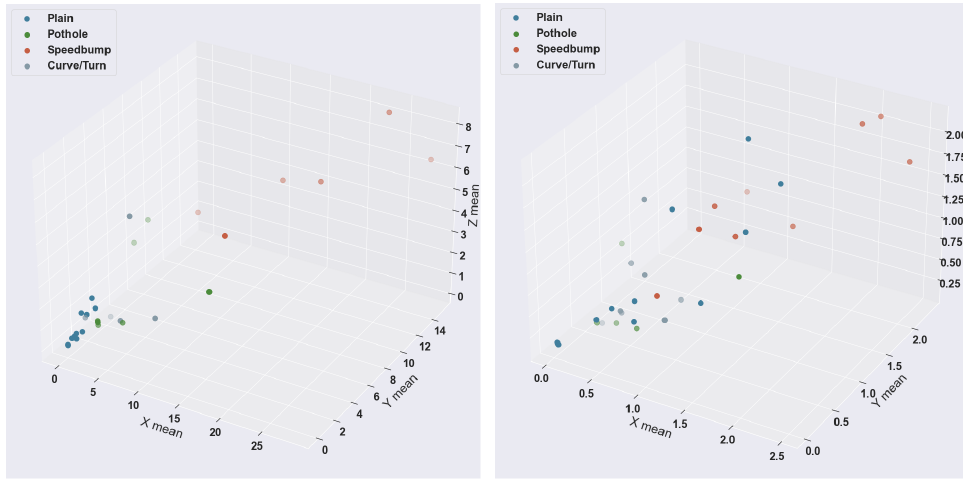
Figure 12. KNN 3D scatter plot ( left ) vs ANN 3D scatter plot ( right